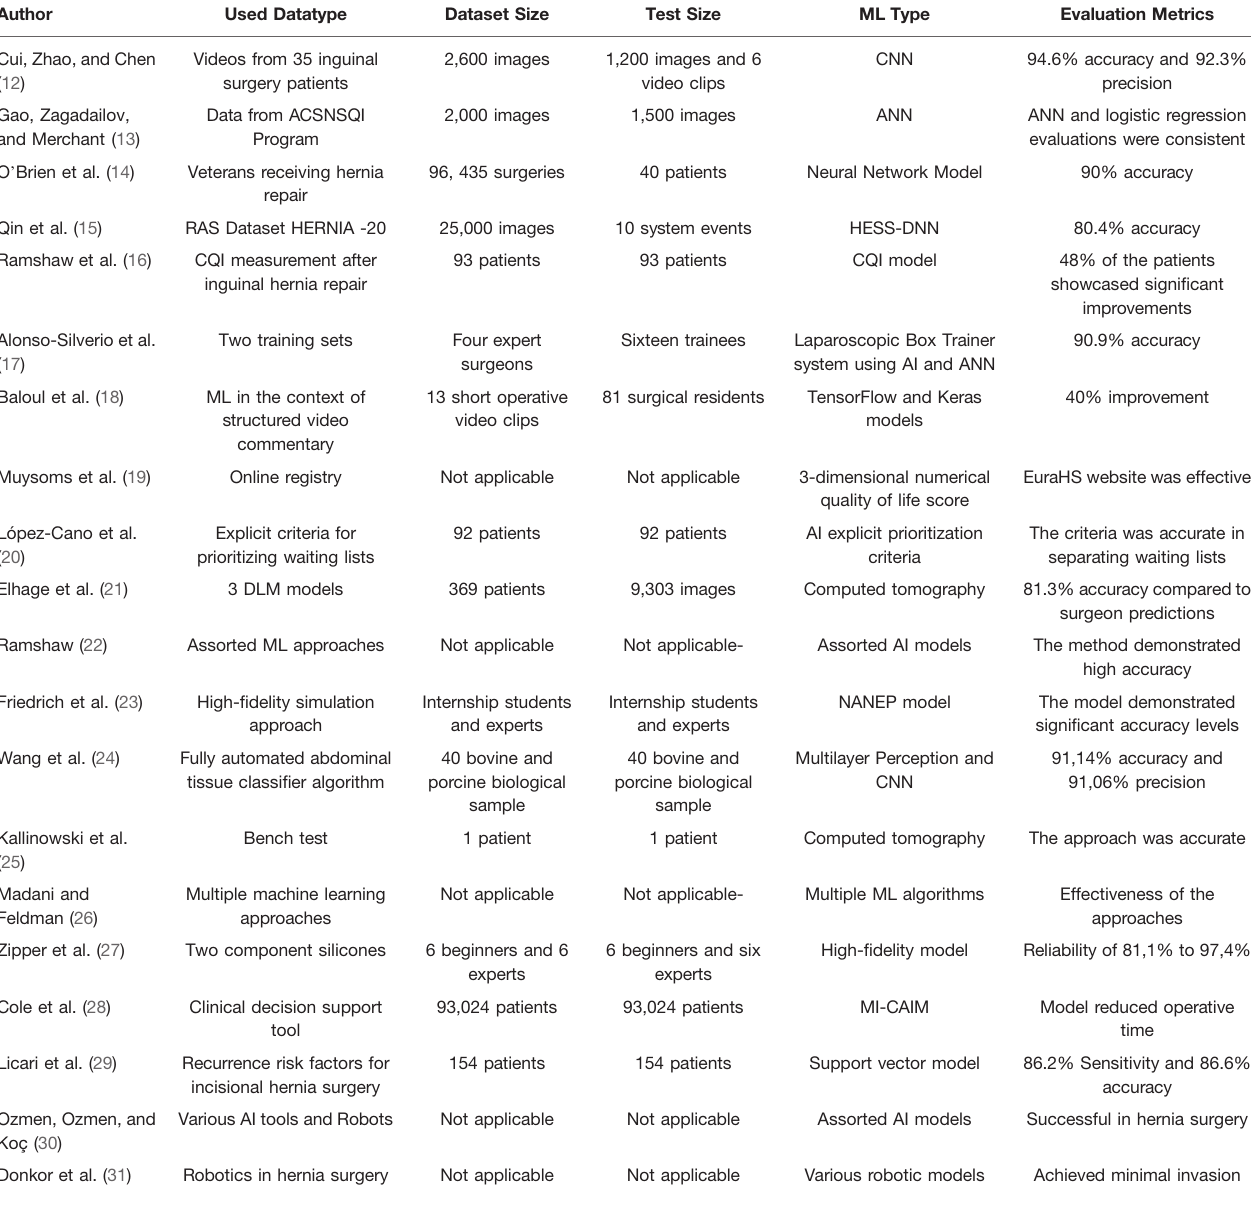
TABLE 2 | Data types, sizes, and evaluation metrics of included